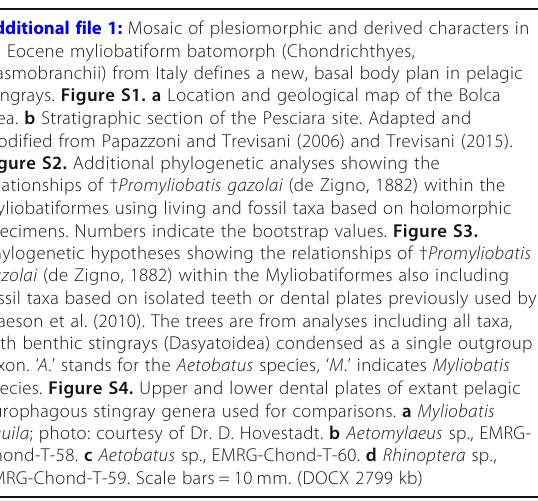
1: Figure S3]. Burnhamia davisei was recovered deeply nested within or sister to Rhinoptera [10], or sister to Mobulidae [9, 42]. Brachyrhizodus was identified as the sister to living Mobulidae [10], or the sister to a clade formed by [ Rhinoptera + Igdabatis ] [42], or, alternatively, in a more basal position within the pelagic stingrays ([9] and this study). The recovering of Sulcidens in polyto- mous relationships even in our analyses [see Additional file 1: Figure S3] makes still uncertain its relative phylo- genetic position [77]. It is therefore likely that this